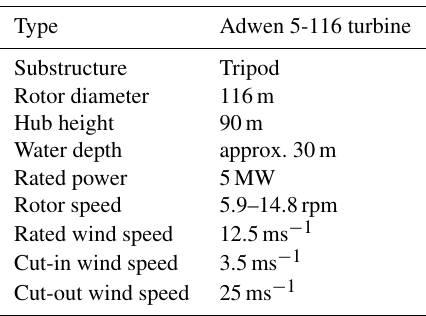
Table 1. Properties of the investigated AV-07 turbine (Bartsch, 2020).